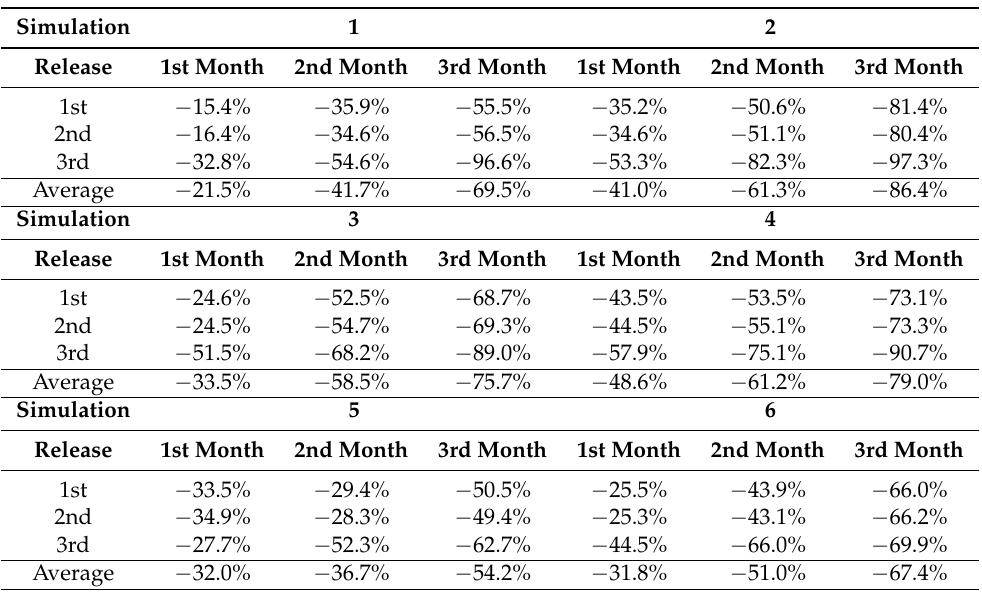
Figure 6. Nowcasting performance for six simulations. Three rows in each subplot represent the first, second, and third month’s nowcasts for the last 20 quarters, respectively. Black curve represents true simulated GDP, and colored curves with different shapes represent nowcasts from different releases. Table 4. This table reports percentages of reduction in MANE relative to RW, which are calculated as ( MANE Bay − MANE RW ) / MANE RW × 100%, for six simulation